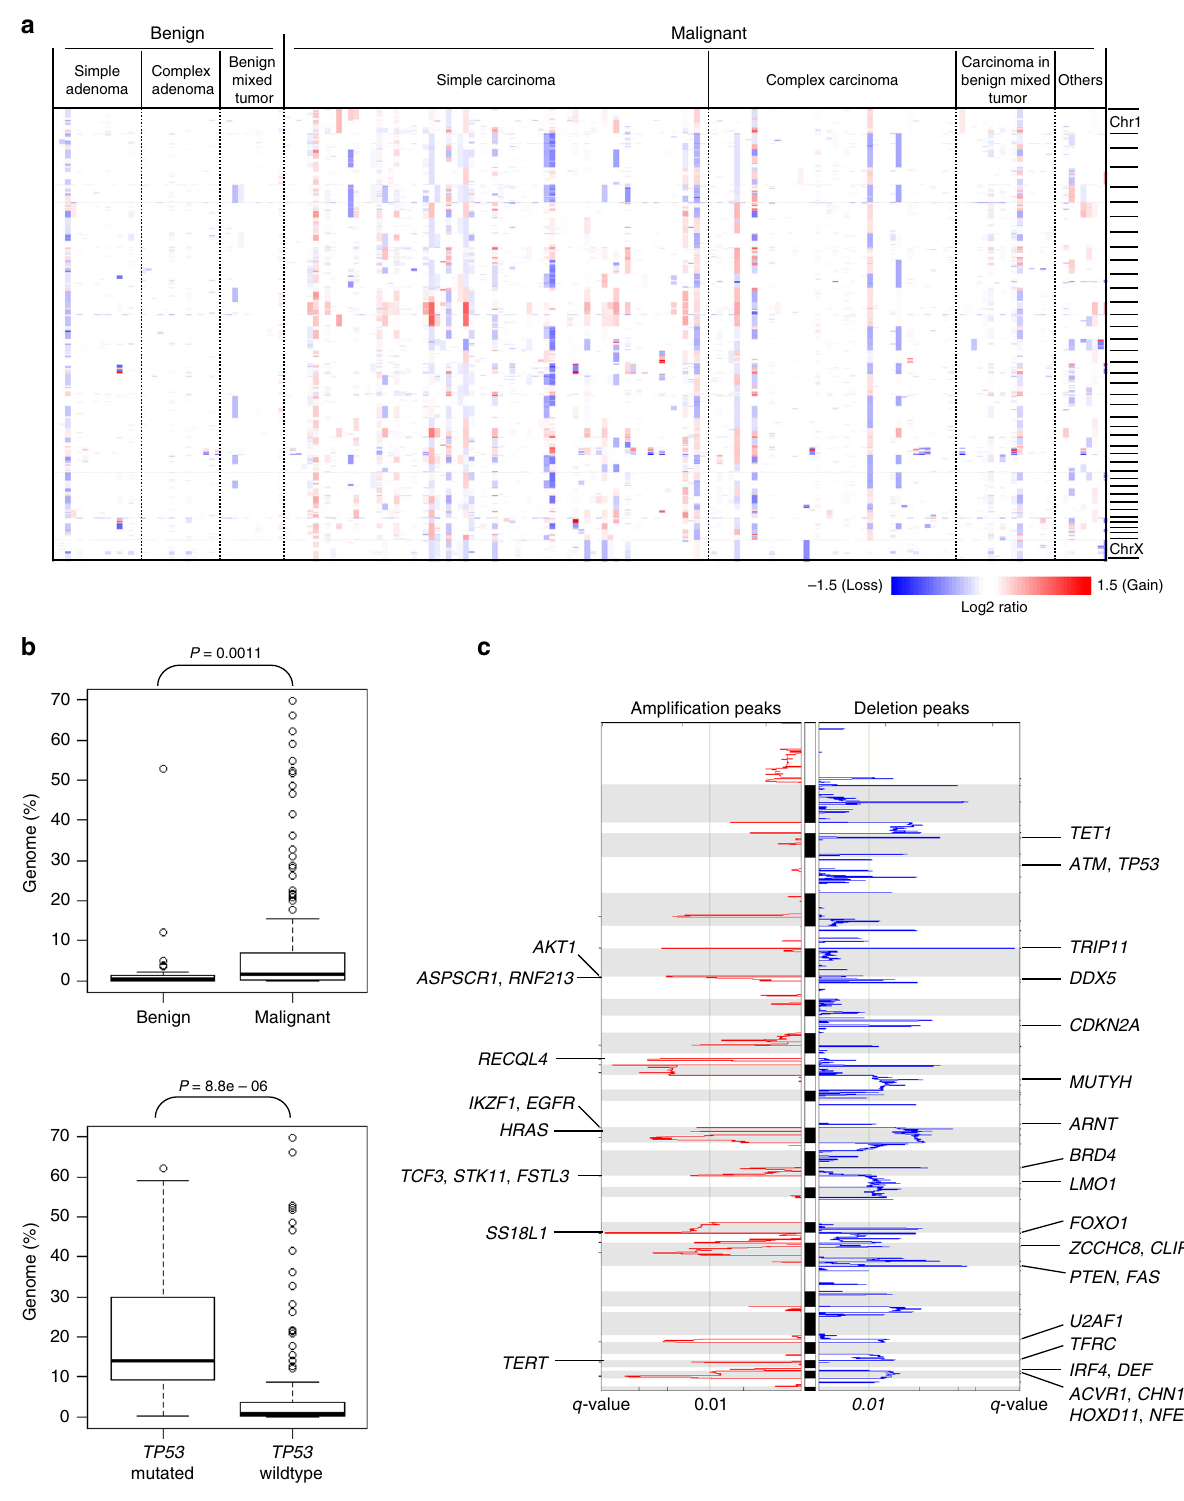
Fig. 2 Somatic copy number alterations (SCNAs) in CMT genome pro fi les. a A genome-wide heatmap of SCNAs is depicted, with red and blue representing chromosomal gains and losses, respectively. The cases are listed in order as in Fig. 1a. b Genome fractions with SCNAs were compared between 40 benign and 143 malignant CMTs, as well as between CMTs with or without TP53 mutations ( n = 16 and 167, respectively). c Ampli fi cation and deletion peaks identi fi ed by GISTIC algorithms are shown across canine genomes with cancer-related genes belonging to the peaks shown. The signi fi cance was estimated by two-sided U